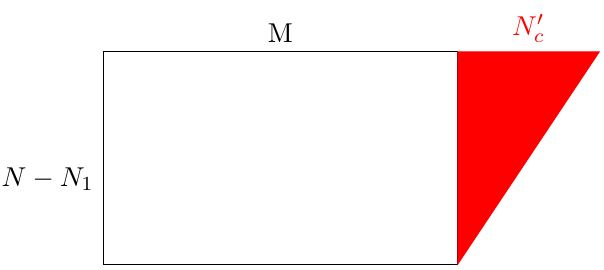
Figure 10 . Young tableau consisting of N 1 fermions in the Fermi sea and N (cid:0) N 1 fermions with some superstar behaviour (red triangle) on top of some excitation M